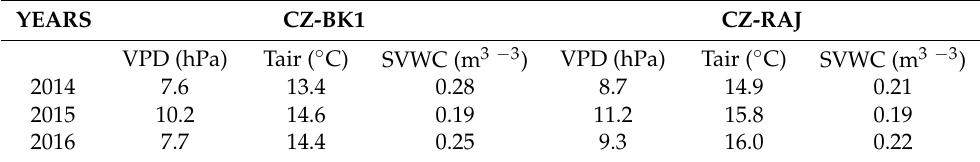
Table 5. Mean values of vapour pressure deficit (VPD), air temperature (Tair) and soil volumetric water content (SVWC) during the main growing season in years for both spruce forest